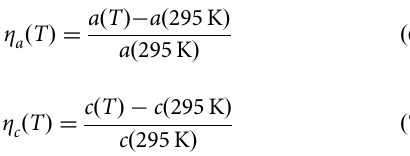
and θ , as shown in a c